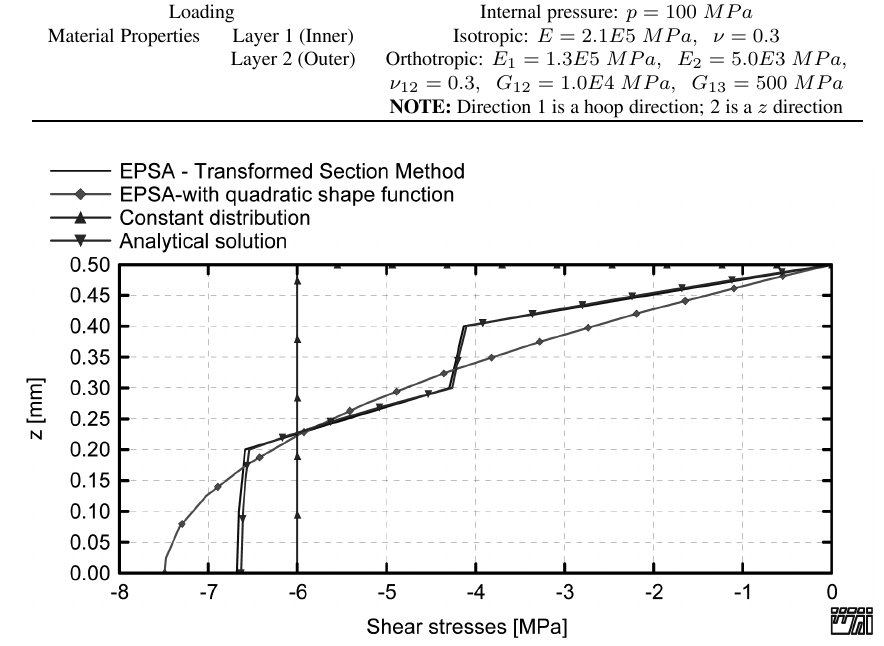
Fig. 10. Distribution of transverse shear stress σ xz [MPa] across the thickness of the composite laminate (Axis of symmetry z = 0.0). leads to inaccuracies in shear stresses. This negatively affects the failure prediction capability of the model. The transformed section method allows for reliable shear stress distribution calculations, and it is simple and ef fi